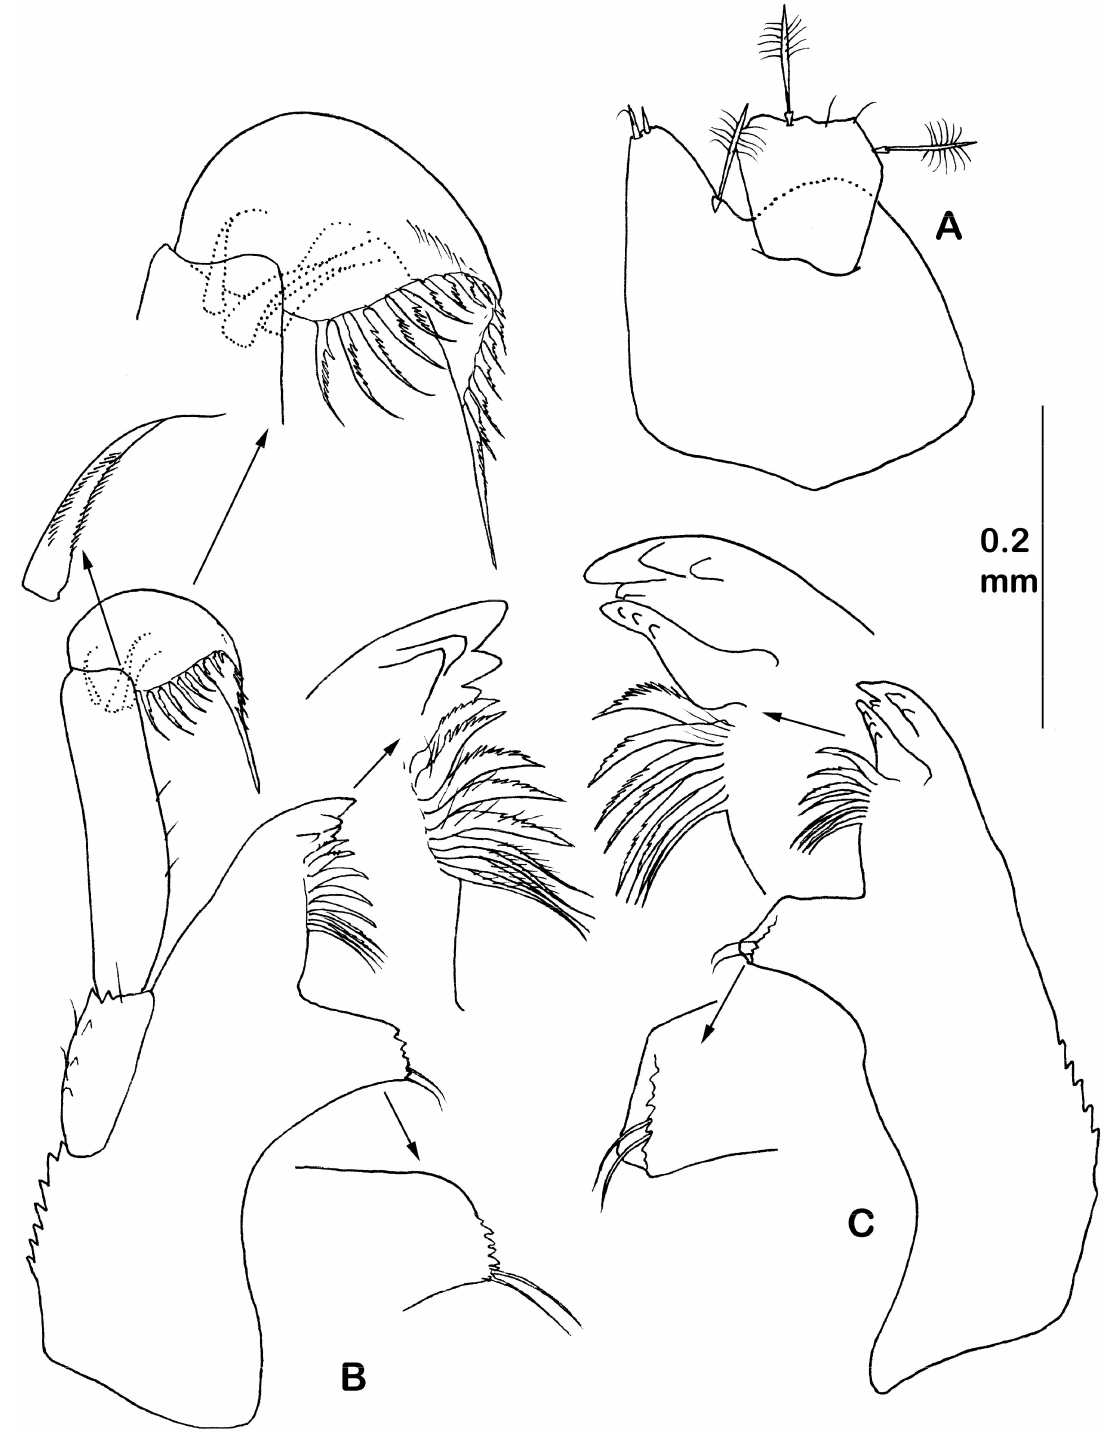
Figure 27. Eurycope emmae sp. nov. Male paratype (ZMH K-45654): ( A ) antenna I, articles 1 and 2; ( B ) right mandible (last palp article, incisor and molar process enlarged); ( C ) left mandibles (incisor and molar process